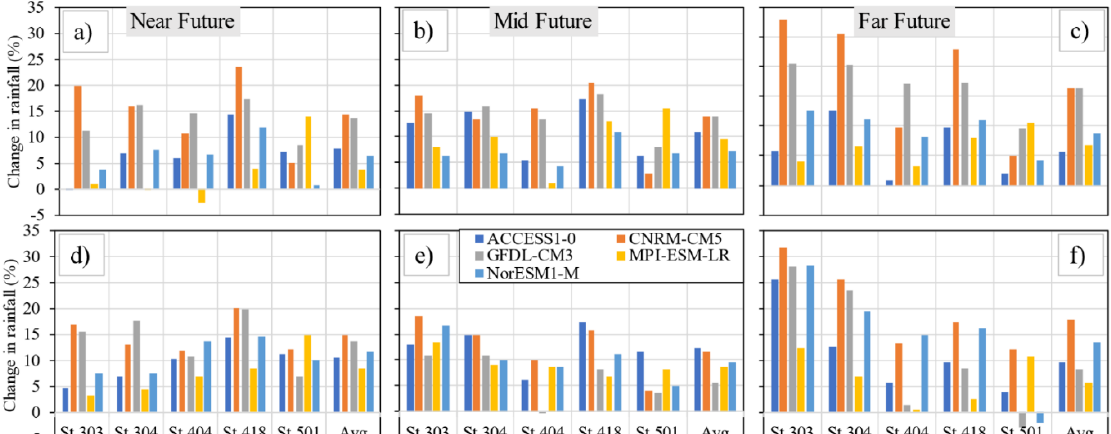
Figure 7. Temporal changes (%) in precipitation pattern at various stations using multiple climate models for three future time windows, namely, Near Future (2020–2040), Mid Future (2041–2070), and Far Future (2071–2100) under 4.5 ( a – c ) and RCP 8.5 ( d – f ). ( a – c ) show the projected rainfall and percentage change in rainfall amount under the RCP 4.5 emission scenario. ( d – f ) show the same under the RCP 8.5 emission scenario. Additionally, ( a , d ) show the same for the near future, ( b , e ) for the mid future, and ( c , f ) for the far future.